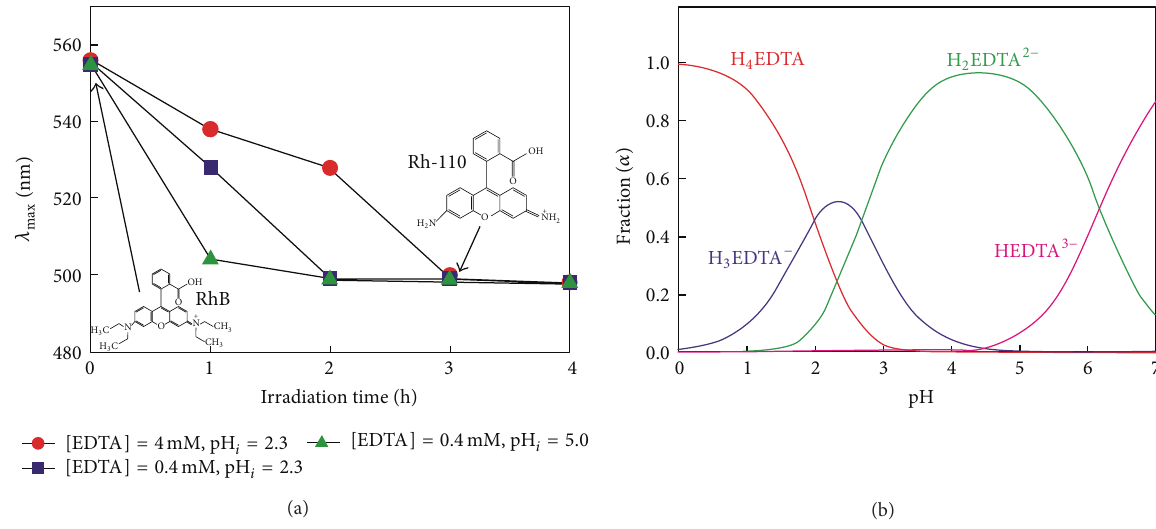
Figure 5: (a) Spectral shift of 𝜆 max depending on [EDTA] and pH 𝑖 . (b) Speciation of EDTA depending on pH. Experimental conditions: [catalyst] = 0.5 gL −1 , [RhB] = 20 𝜇 M, [EDTA] = 4 mM, pH 𝑖 = 2.3 , and 𝜆 > 420 nm. Samples were diluted by 3 times for the analysis. The stepwise acid dissociation constants (p 𝐾 𝑎 ) of EDTA are p 𝐾 𝑎1 = 1.99 , p 𝐾 𝑎2 = 2.67 , p 𝐾 𝑎3 = 6.16 , and p 𝐾 𝑎4 = 10.26